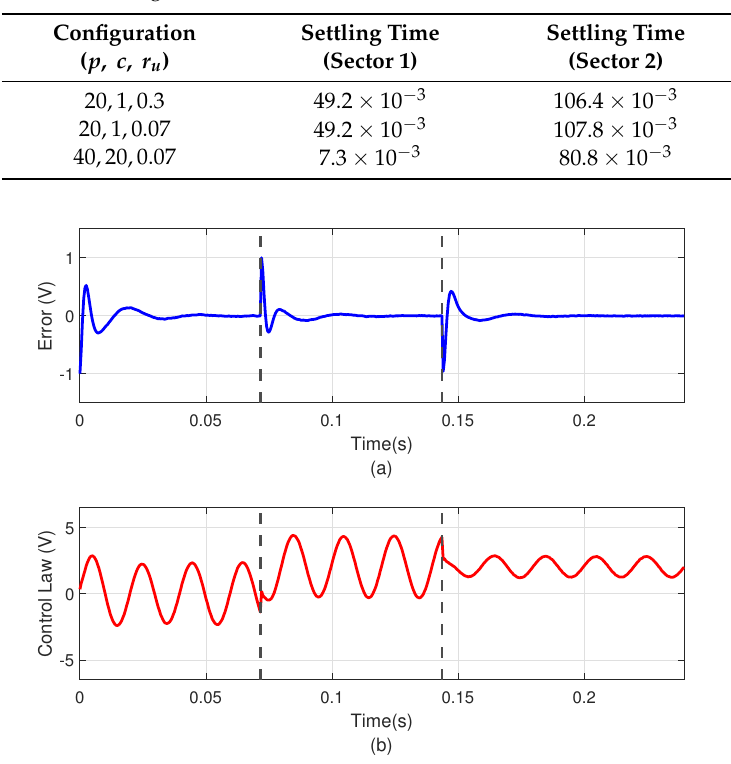
Table 2. Settling Time for Test 1.